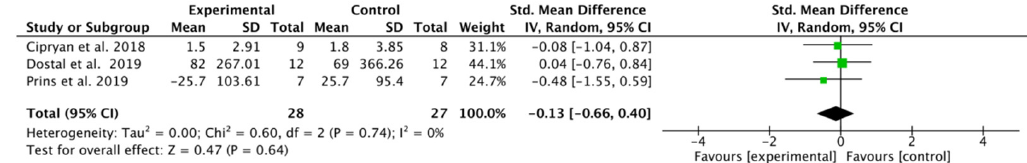
Figure 4. Effect of the ketogenic low-carbohydrate, high-fat (K-LCHF) diet on total time to exhaustion (TTE) during graded exercise test (GXT); CI: confidence interval; SMD: standardized mean difference.